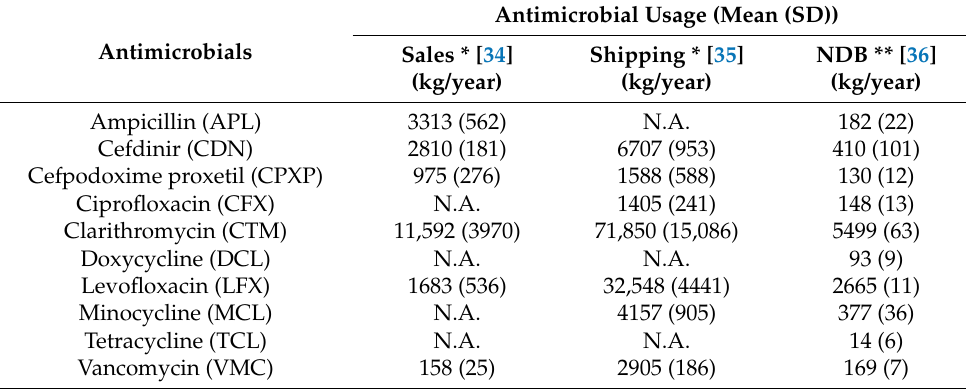
Antimicrobial Usage (Mean